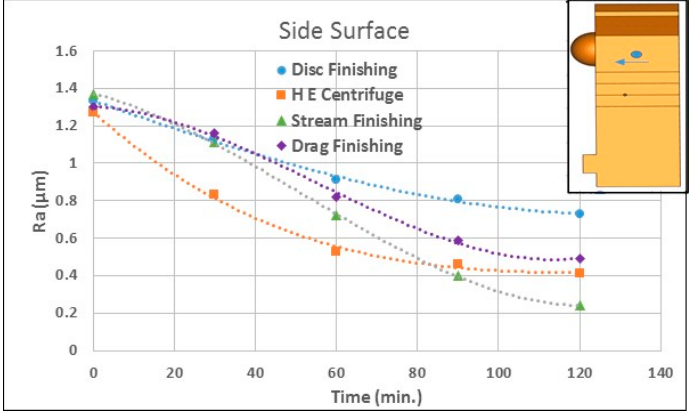
Figure 10. Surface roughness comparison on angle surface (blue arrows show direction of measurement).